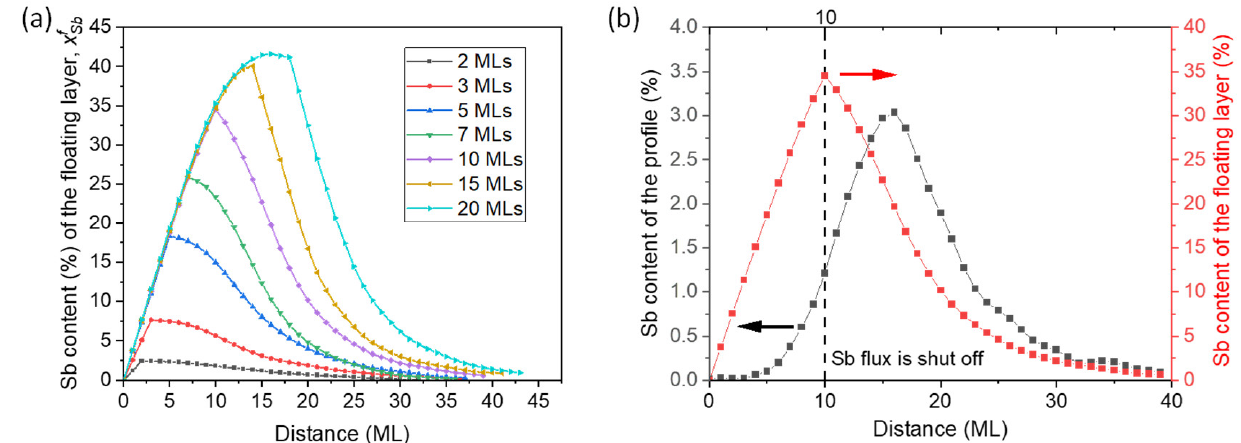
Figure 7. ( a ) Values of the Sb contents of the floating layer during the growth of the different GaAsSb layers. All the layers reach the maximum content at the end of the superficial impinging of Sb, decaying exponentially to vanish completely at the end of the GaAsSb layer. ( b ) Sb content profile of the epitaxy (left, black dots) together with the evolution of the floating layer (right, red dots) for the layer with 10 MLs of GaAsSb.